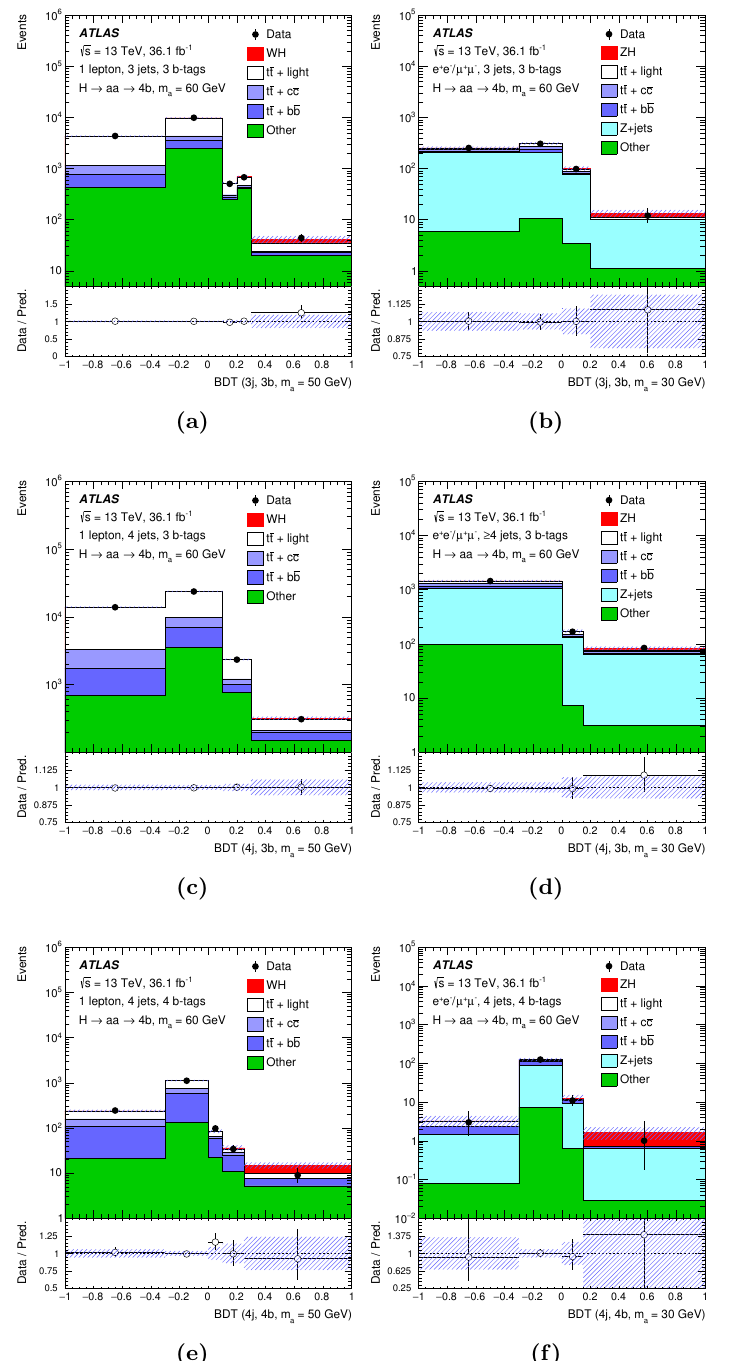
Figure 8. Comparison between data and prediction for the BDT discriminants in the (left) single- lepton signal regions trained with a signal with m a = 50 GeV: (a) (1 ‘ , 3j, 3b), (c) (1 ‘ , 4j, 3b) and (e) (1 ‘ , 4j, 4b) and in the (right) same-(cid:13)avour dilepton signal regions trained with a signal with m a = 30 GeV: (b) (2 ‘ , 3j, 3b), (d) (2 ‘ , 4j, 3b) and (f) (2 ‘ , 4j, 4b), after performing (cid:21) (cid:21) (cid:21) the combined single-lepton and dilepton (cid:12)t of the predictions in all SRs and CRs to the data. The signal yield (solid red) is normalized to ^ (cid:22) after the (cid:12)t for a signal with m a = 60 GeV.